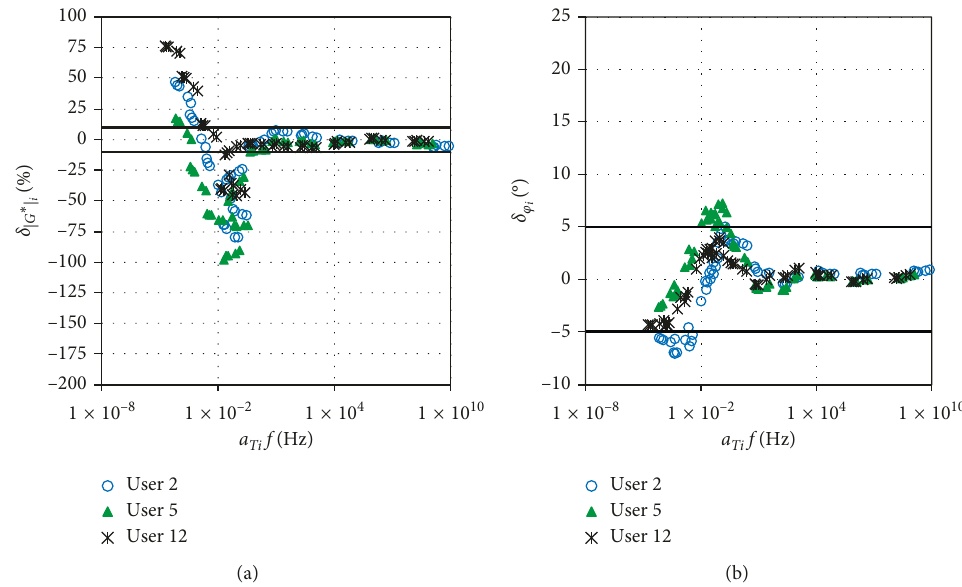
Figure 6: Errors between 2S2P1D simulations of the three most experienced users of the panel and experimental data for the bitumen G 10.00 ° C): relative error (a) and absolute errors for φ (b). Bold lines represent 10% and 5 ° limits for, respectively, relative and ( T ref (cid:31) | | absolute errors. ∗